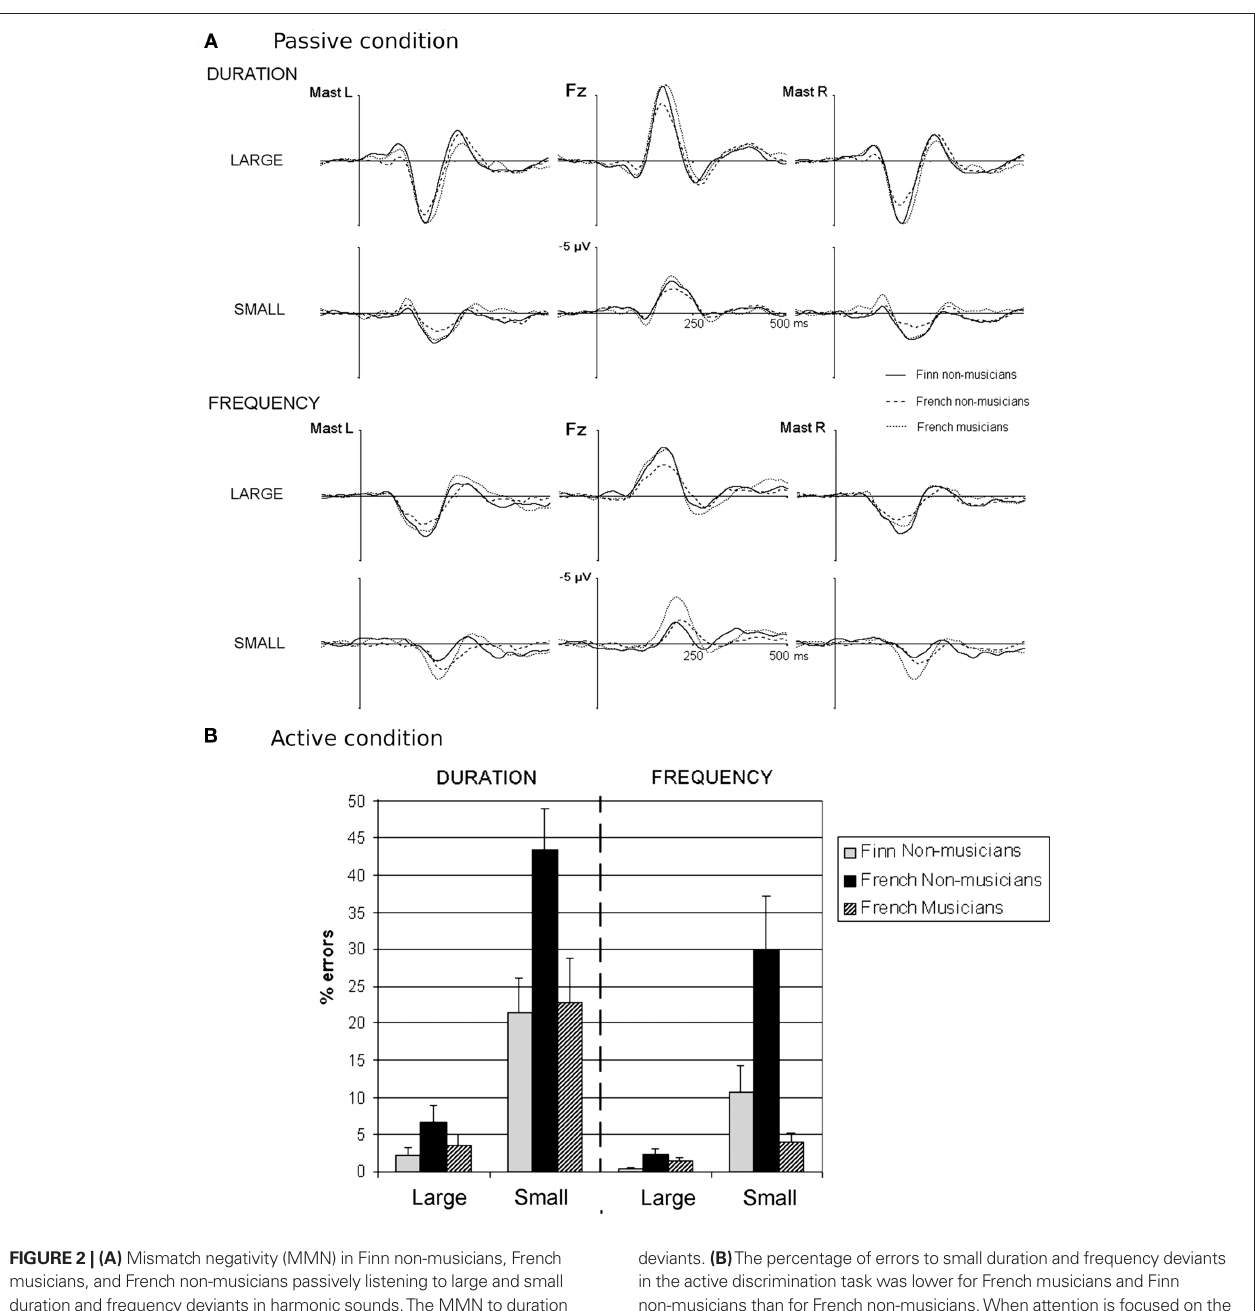
Figure 2 | (A) Mismatch negativity (MMN) in Finn non-musicians, French musicians, and French non-musicians passively listening to large and small duration and frequency deviants in harmonic sounds. The MMN to duration deviants was larger in Finn and in French musicians than in French non- musicians. However, only the French musicians showed an enhanced MMN to small frequency deviants. Thus, linguistic and musical expertise similarly influenced the pre-attentive processing of duration but not of frequency